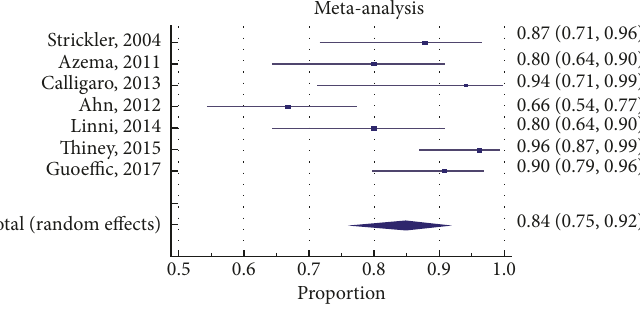
Figure 4: Forest plot for primary patency at 1 year in EVT RS group. Table 5: Showing the details of the studies included in the